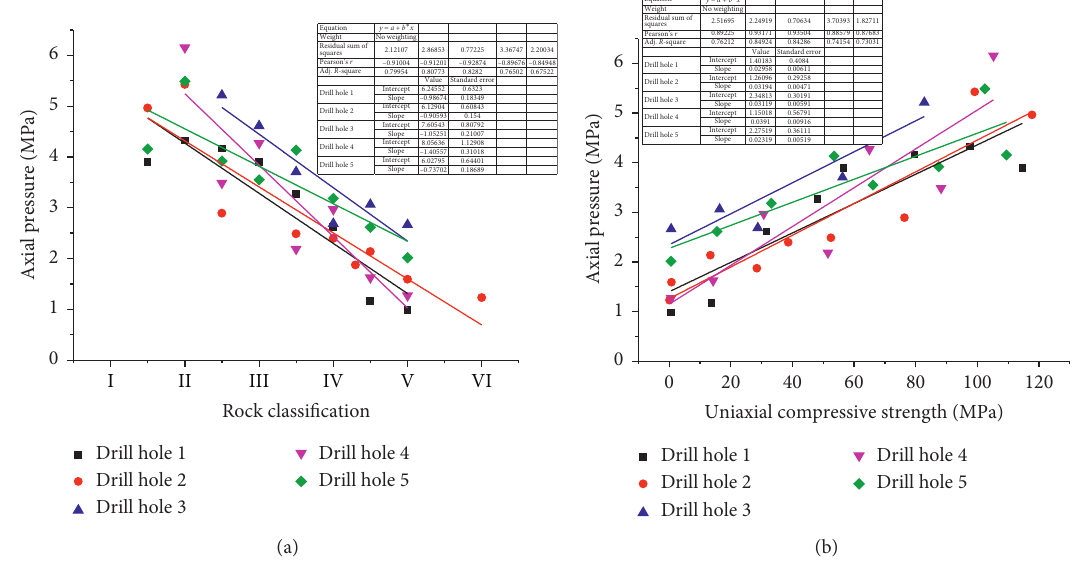
Figure 10: Relationship between rock classification, compressive strength, and axial